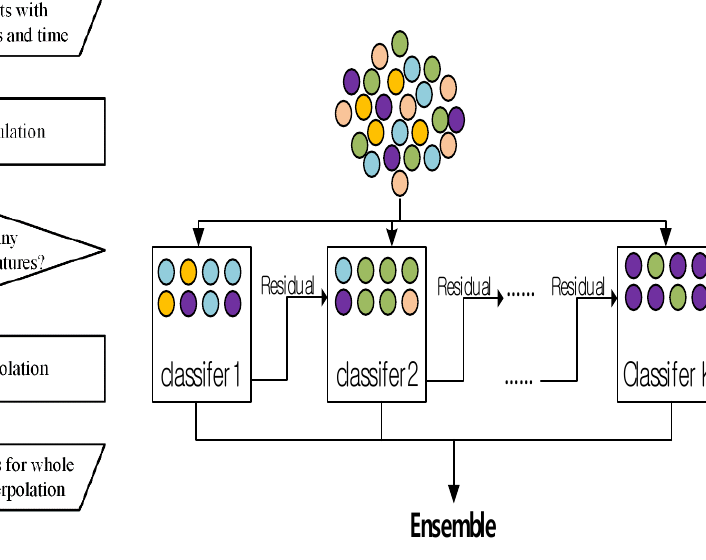
Figure 3 . Classification using Gradient Boosting